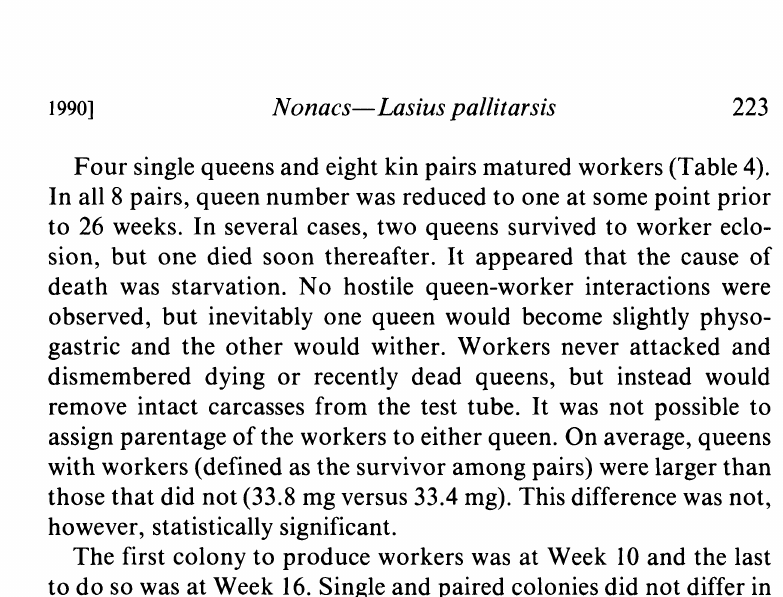
Table 3: Lifespan and initial weights of queens. Values in parentheses are N’s. Victor and loser refer to which queens survived or died first in the pairs. Larger and smaller refer to the initial size relationship of queens in the pairs. Values that are significantly different (p < 0.05) are noted by a (T-test) and b (Wilcoxon signed-rank